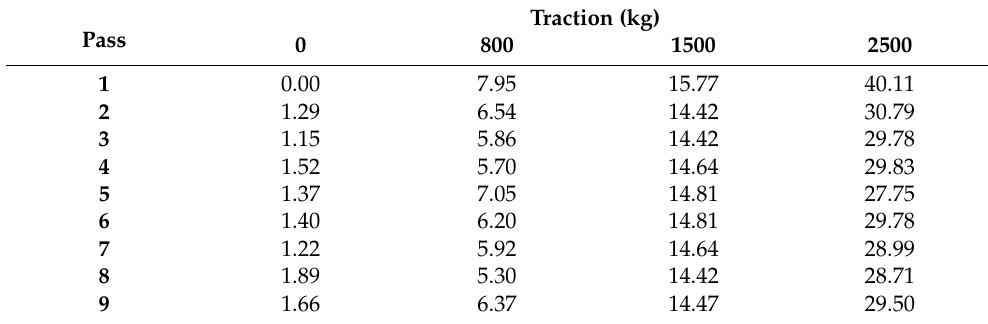
Table 3. Slip rate (%) under repeated